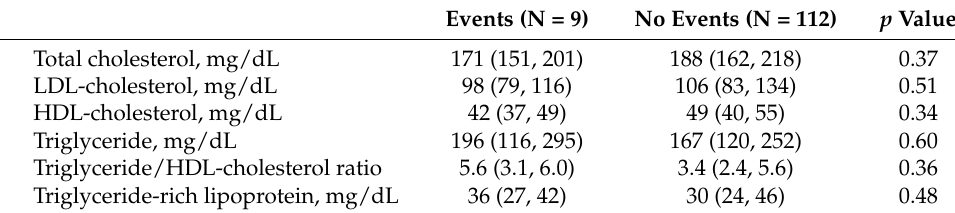
Table 4. The lipid parameters at 3-month follow-up stratified by experiencing an adverse cardio- vascular event.